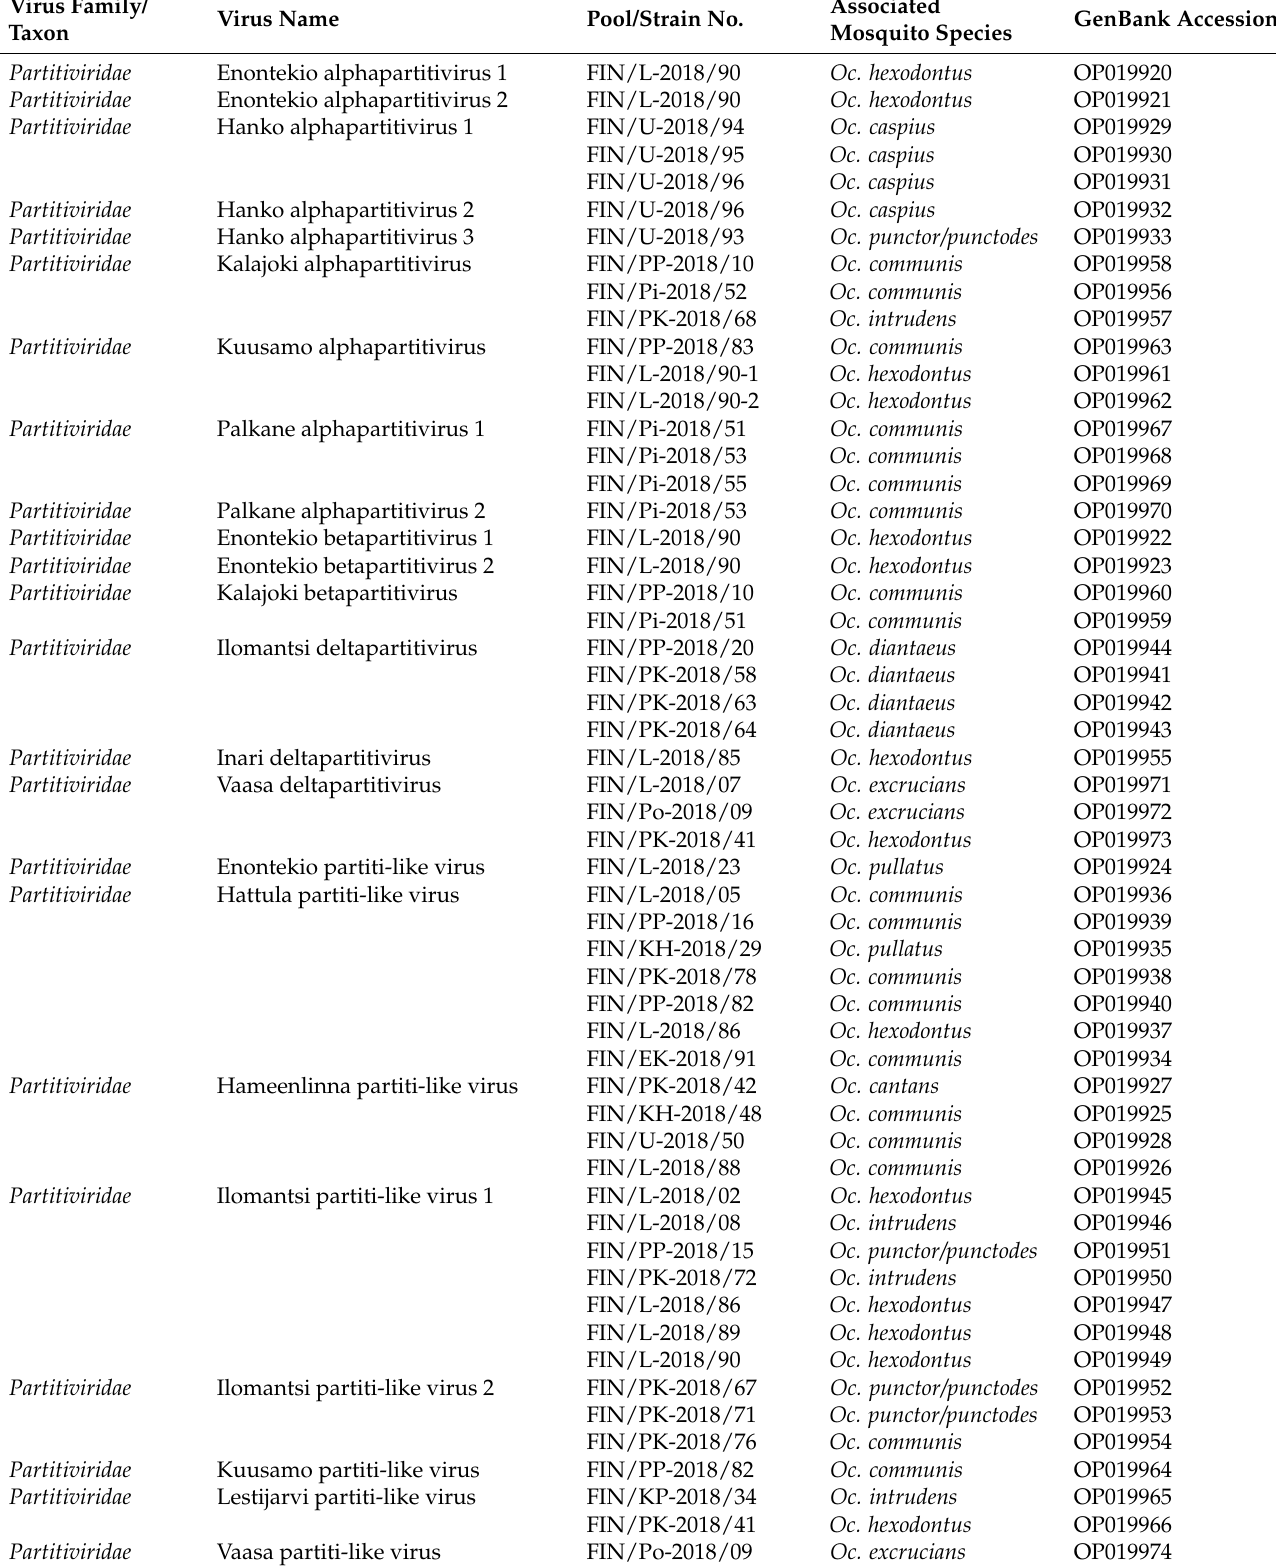
Table 6. dsRNA viruses sequenced from Finnish mosquitoes, part 2, Partitiviridae